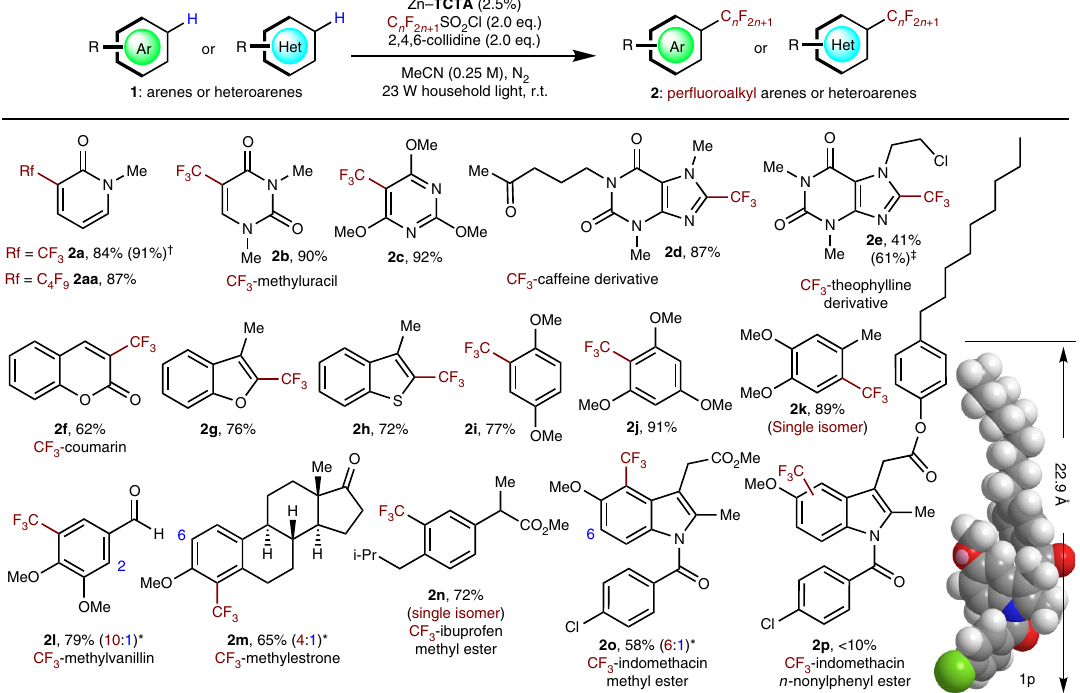
Fig. 5 Scope of photocatalytic tri fl uoromethylation of aromatics by Zn – TCTA . Reaction conditions: 1 (0.25 mmol, 1.0 equiv), RfCl ( fl uoroalkylation reagent as speci fi ed, 2.0 equiv), base additive (2.0 equiv), Zn – TCTA (0.025 equiv), MeCN (1 mL), 23 W household light, N 2 atmosphere, room temperature, 24 h. Isolated yields. † 15 mmol-scale reaction. ‡ 3.0 equiv of TfCl and collidine. * Only major regioisomers are shown. The minor regioisomeric sites are labelled with their carbon atom numbers